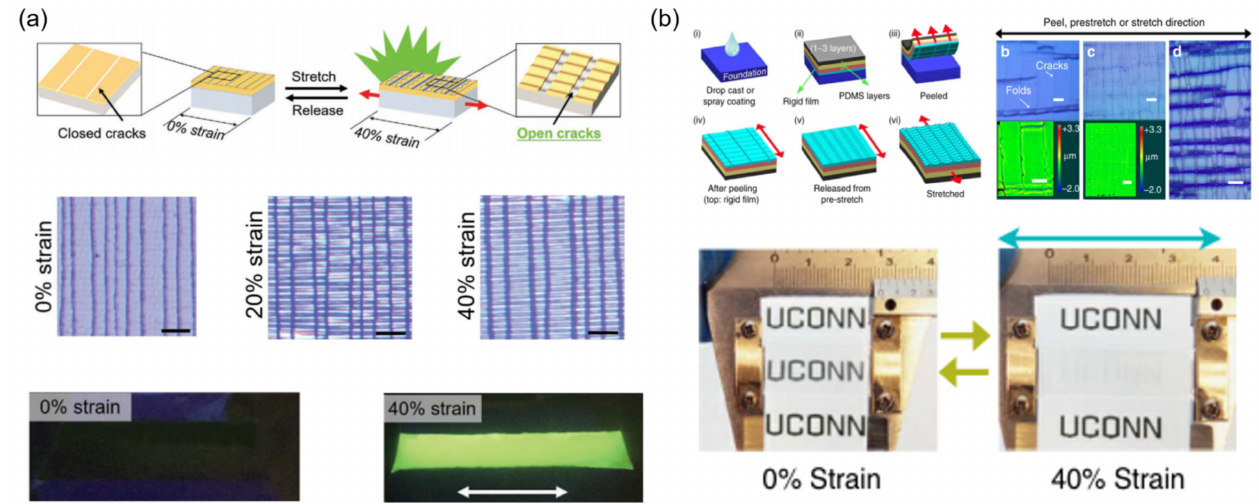
Figure 3. Construction paths of mechanoresponsive smart windows based on surface crack: ( a ) surface deposition of metal coating [34] Copyright 2017, John Wiley and Sons, ( b ) soft substrate/ hard shell [35] Copyright 2017, John Wiley and